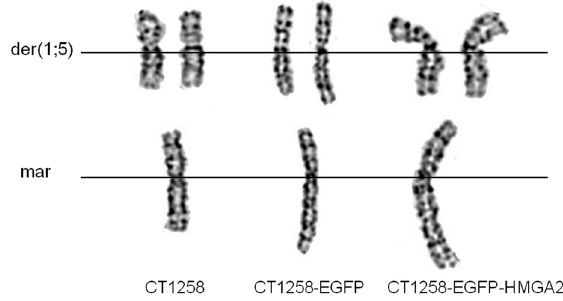
Figure 8. Details of CT1258 chromosomal aberrations. Detailed presentation of chromosomal aberrations found in metaphases of CT1258, CT1258-EGFP and CT1258-EGFP-HMGA2. Two derivative chromosomes (der(1;5)) and the large bi-armed marker chromosome (mar) were found in each cell line.